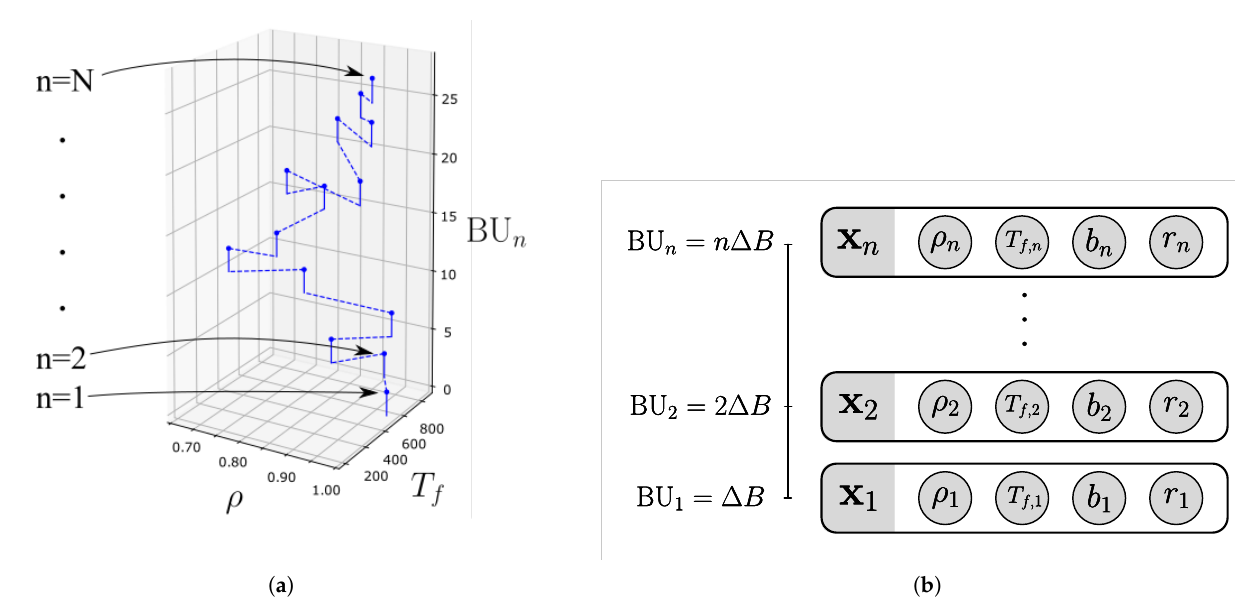
Figure 2. Structure of burnup sequences. ( a ) depiction of coolant temperature and fuel temperature change over burnup for a single burnup sequence sample; ( b ) structure of state vectors and evolution through burnup. Each component of ⃗ x is independently sampled from their respective